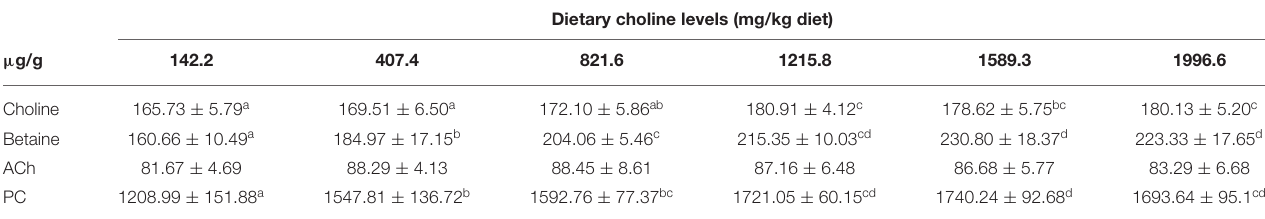
Dietary choline levels (mg/kg diet)